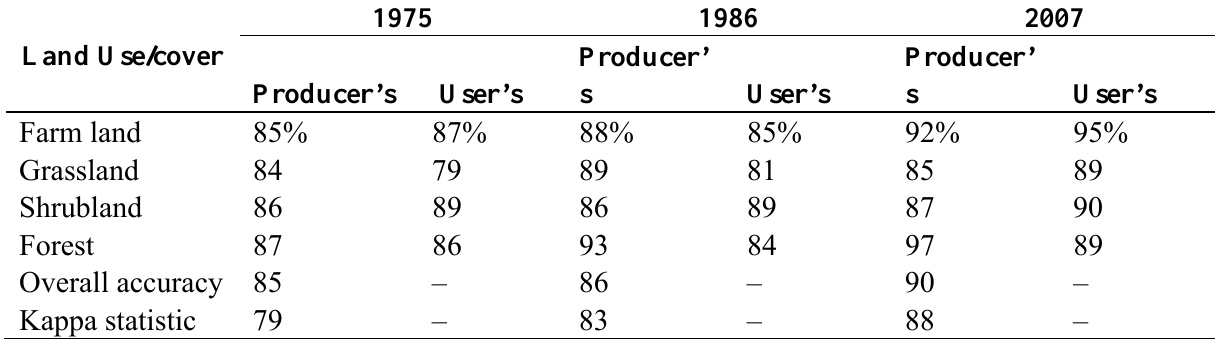
Table 2. Summary of land use/cover classification accuracies for 1975, 1986 and